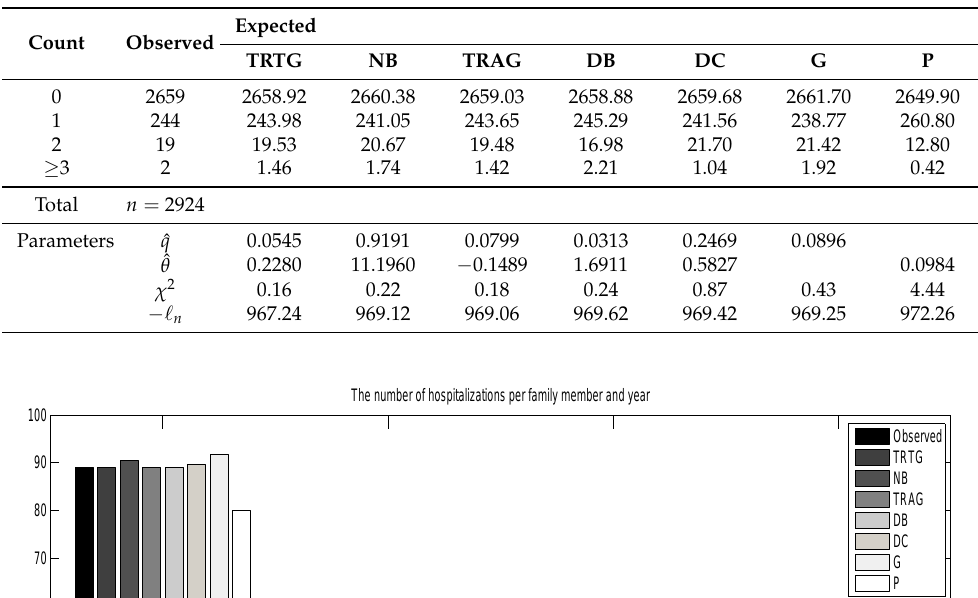
Figure 4. Observed and fitted distributions for second data. Table 7. Results of observed and expected frequencies, χ 2 and − (cid:96) n , respectively, for third data.